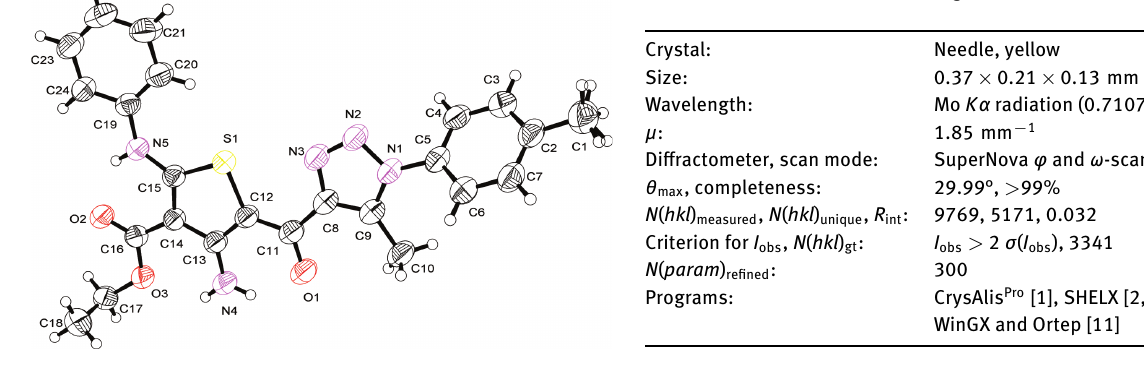
Table 2: Fractional atomic coordinates and isotropic or